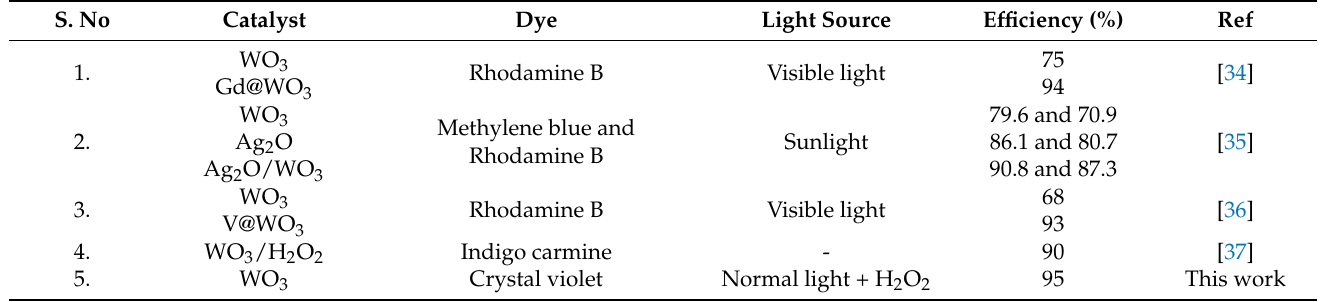
Figure 10. Photocatalytic degradation of ( a ) CV, ( b ) MB, and ( c ) RB and ( d ) dyes-degradation efficiency. Table 1. Catalytic efficiencies of different WO 3 materials for different dye